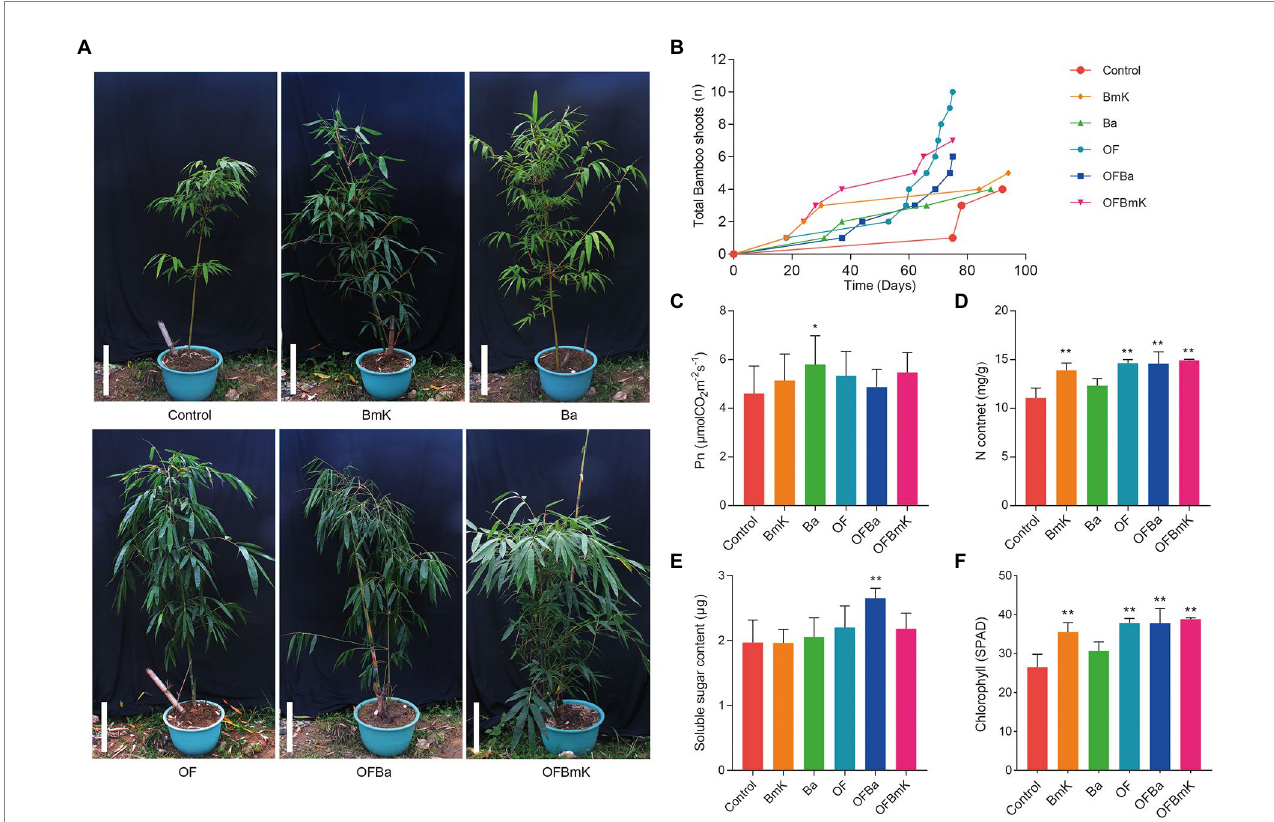
FIGURE 1 Effect of bio-organic fertilization on the growth of Dendrocalamus farinosus . (A) The phenotypes of D. farinosus 90 days after the initiation of fertilization. Scale bar, 50 cm. (B) Statistical analysis of the total number of bamboo shoots produced by each plant and the duration of bamboo shoot formation. Determination and analysis of net photosynthetic rate (C) , nitrogen content (D) , soluble sugar content (E) , and chlorophyll content (F) in bamboo leaves. One-way ANOVA and Tukey post-hoc tests were used to calculate the differences between treatment groups. * p < 0.05; ** p < 0.01. BmK–OFBmK refers to the different fertilization regimens: BmK, Bacillus mucilaginosus Krassilnikov ; Ba, Bacillus amyloliquefaciens ; OF, organic fertilizer; OFBa, bio-organic fertilizer (containing Bacillus amyloliquefaciens ); OFBmK, bio-organic fertilizer (containing Bacillus mucilaginosus Krassilnikov